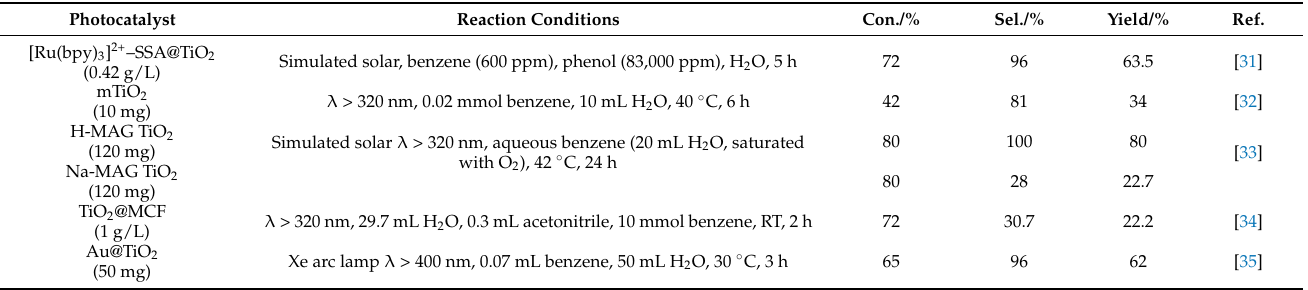
Table 1. Catalytic performance of semiconductor-based photocatalysts for benzene hydroxylation. Photocatalyst Reaction Conditions Con./% Sel./% Yield/%